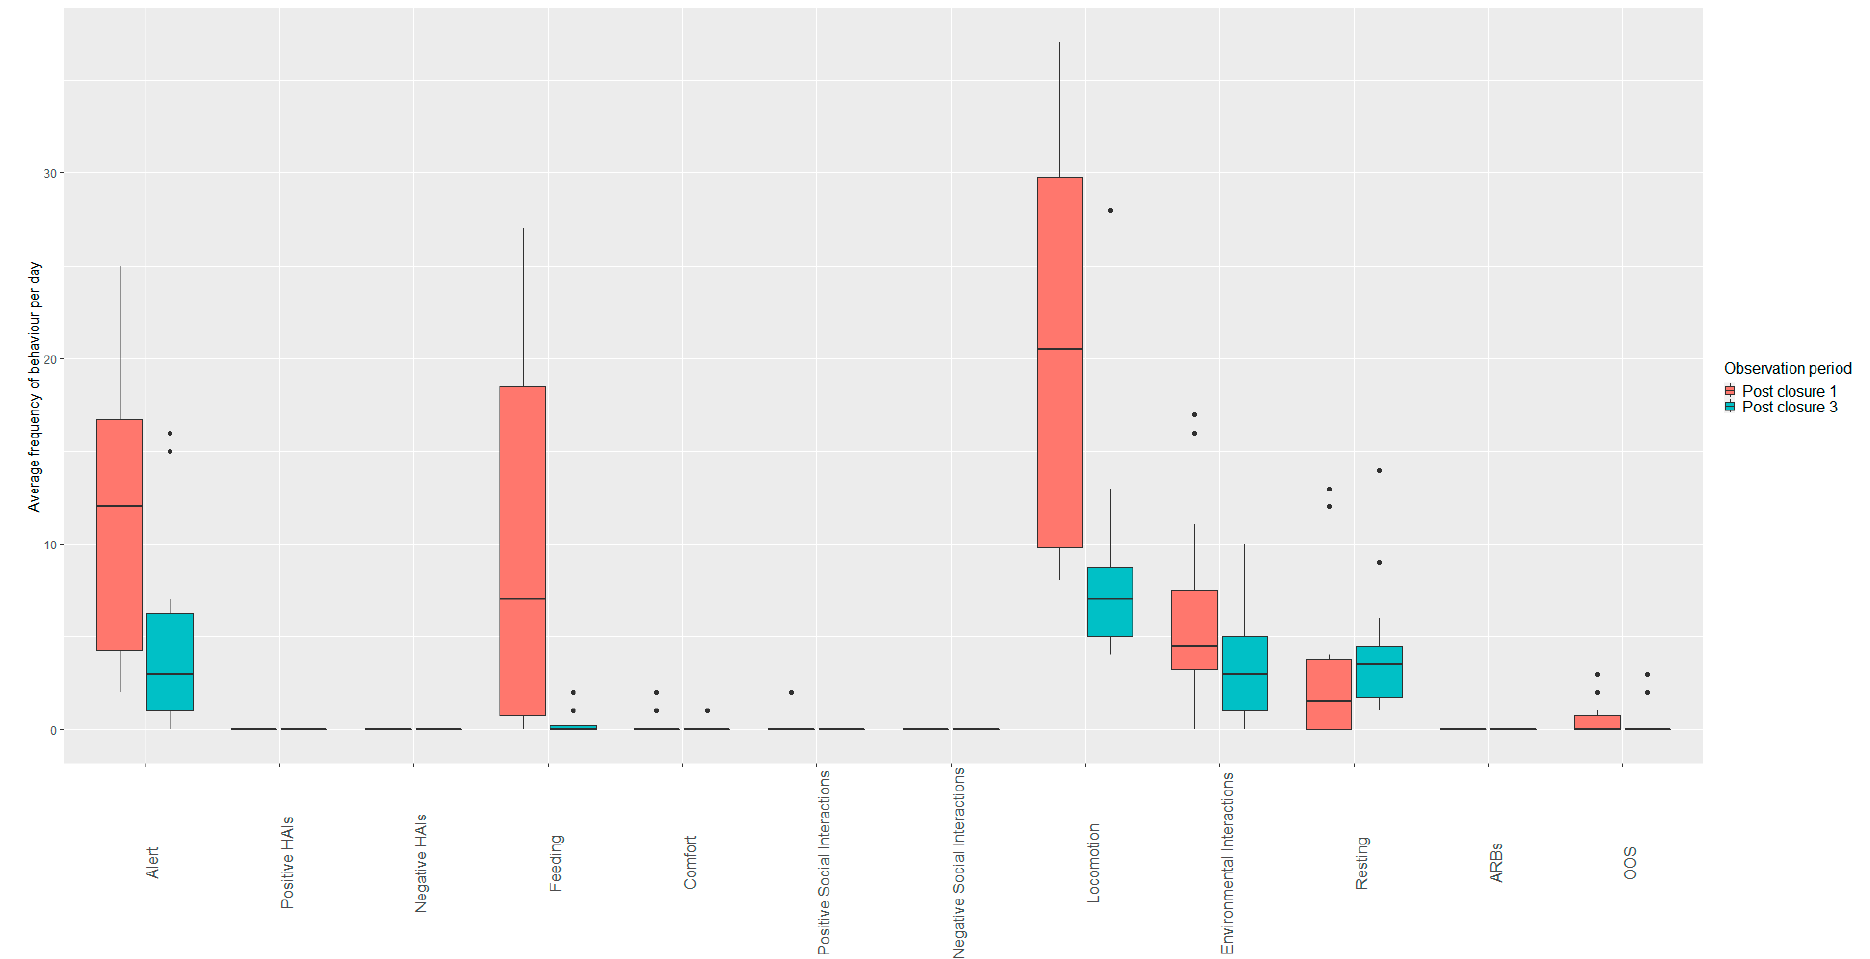
Figure 9. An overview of activity throughout the closure and reopening periods for meerkats housed at Dartmoor Zoo. Dots represent outliers.